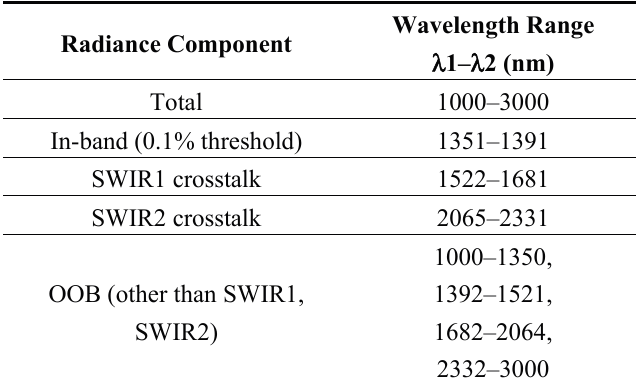
Table 7. Wavelength ranges for radiance components in spectral crosstalk analysis for the Cirrus band. The in-band ranges for all three bands were determined from the 0.1% response points of each band’s response curve.